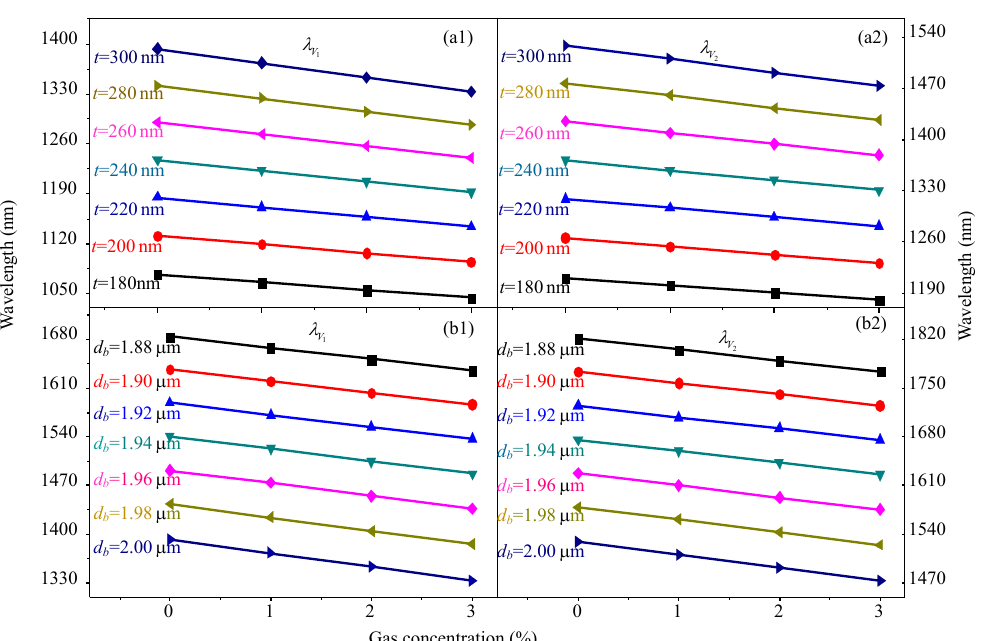
Fig. 4 Methane concentration C related to the resonance wavelength of (a1) different d b , and (b2)  at different d b under the condition of T = 20 ℃ 2 V